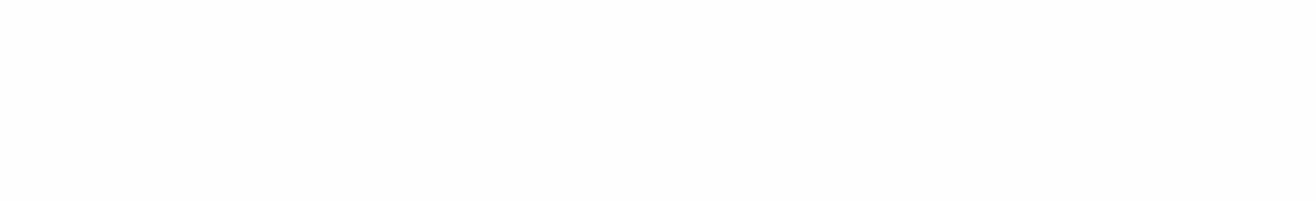
shows the largest Lyapunov exponent for the Lewis oscillator (1) as a function of the step size when integrated according to a standard forward Euler algorithm ( =0.1 and initial con- ditions x0=Y0=0.01). This figure shows unequi- vocally that up to a step size h*0.45 the computed LCE remains approximately zero, as expected for the limit cycle. Beyond that value begins an increasingly intricate dynamics, due to an assortment of numerically induced instabilities, that includes numerous n-periodicity windows, chaotic regions and finally a breakdown at h 1.178 due to numerical overflow. This